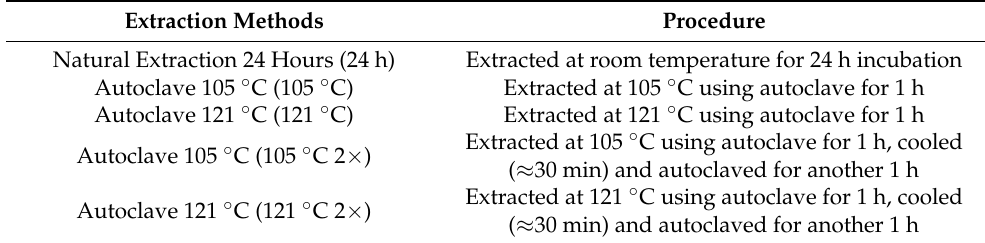
Table 6. Type of soil extraction methods and the procedure used. Extraction